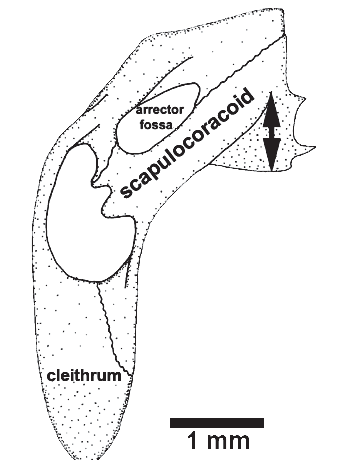
Fig. 3. Ventral view of right pectoral girdle of Scleromystax salmacis , paratype, MCP 29299, 33.2 mm SL. Double-headed arrow showing orientation of the proximal portion of the ven- tral keel of the